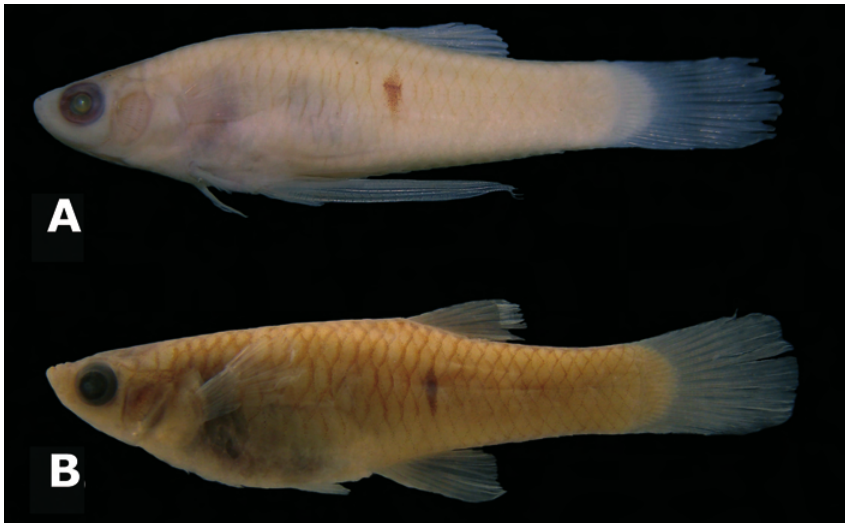
Fig. 13. Phalloceros tupinamba . (A) Holotype, male, 22.4 mm SL, MCP 30408, rio Macacu, Cachoeiras de Macacu, Rio de Janeiro, Brazil; (B) paratype, female, MCP 20585, collected with the holotype.